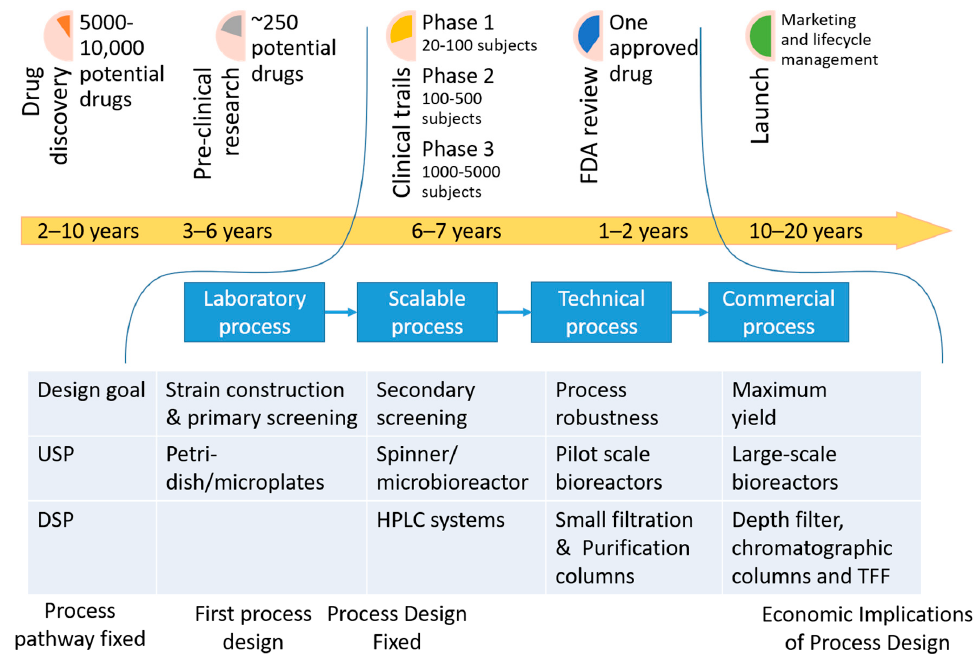
Figure 2. Lifecycle of a drug from discovery to mass market availability. Abbreviations: DSP (Downstream processing), HPLC (High performance liquid chromatography), TFF (Tangential-flow filtration system), USP (Upstream